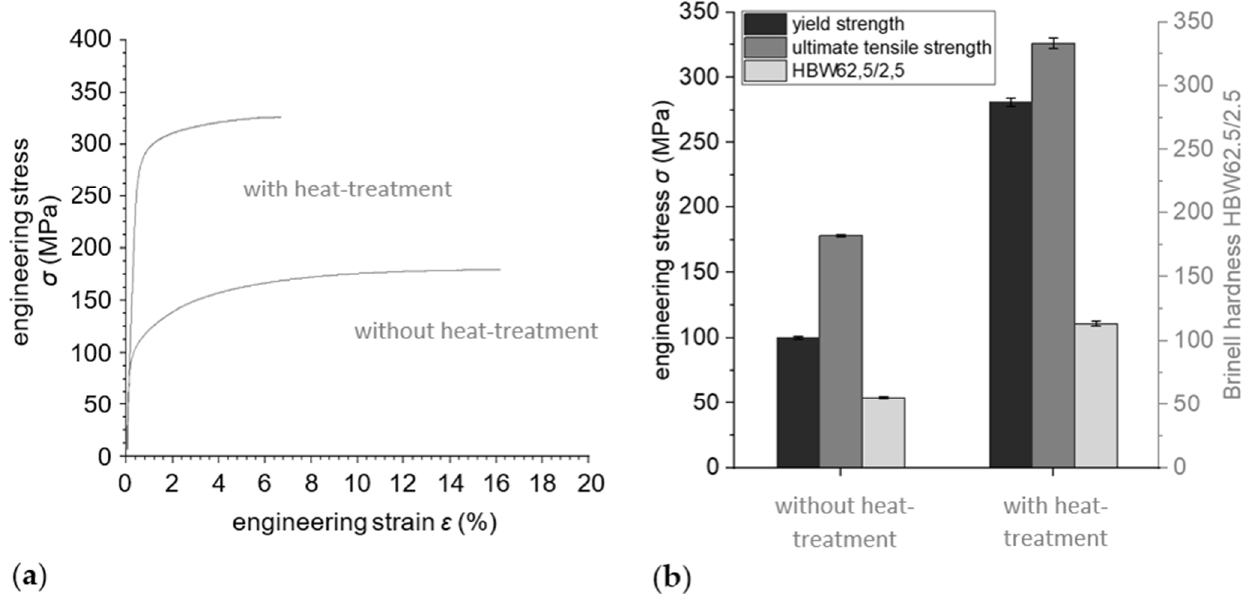
Figure 4. ( a ) Tensile behavior and ( b ) mechanical properties of the FAST-sintered A357 powder alloy. By heat treatment, yield and ultimate tensile strength were significantly increased, but the ductility was decreased.